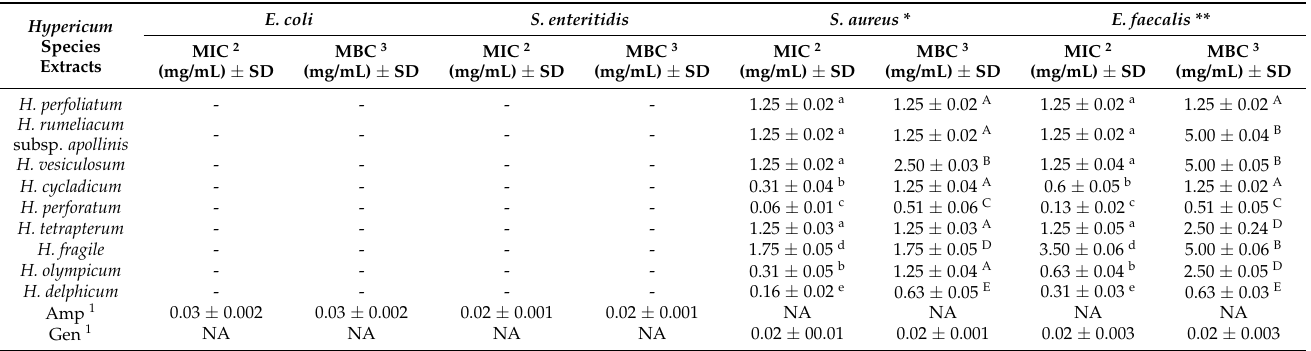
Gram-positive bacteria, respectively; 2 The smaller the MIC value, the less extract is required for bacterial growth inhibition. Substances with MIC values of <0.6 mg/mL are regarded as strong in-